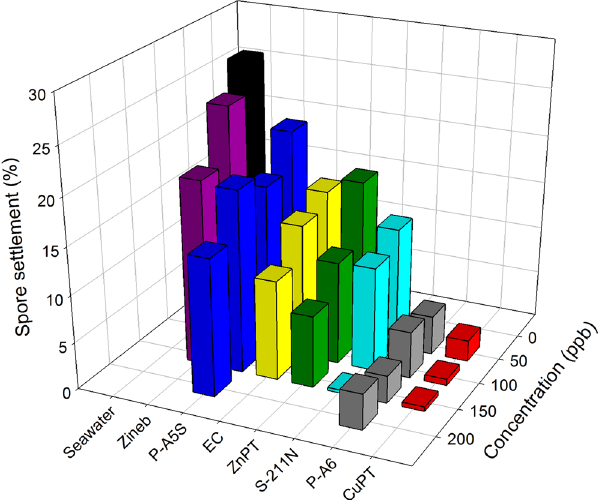
Figure 2. Settlement efficiency of Ulva spores in natural seawater containing each biocide as a function of biocide concentration (n = 3). The values and standard deviations are presented in Supplementary Table